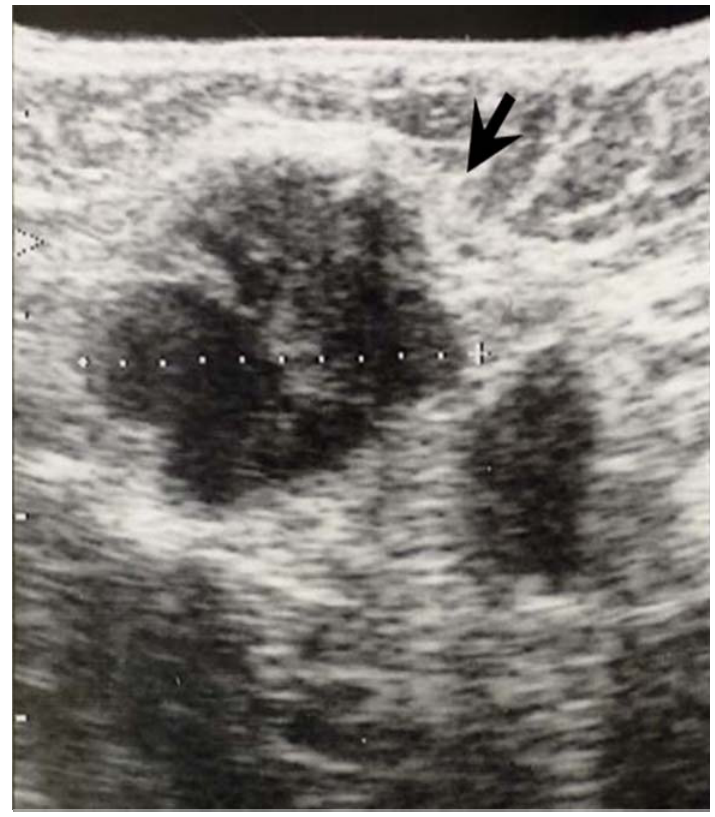
Figure 6 . Ultrasonographic appearance of type 3 lymph node metastases. This lymph node (arrow) shows clearly defined boundaries but scattered large internal echoes accompanied by